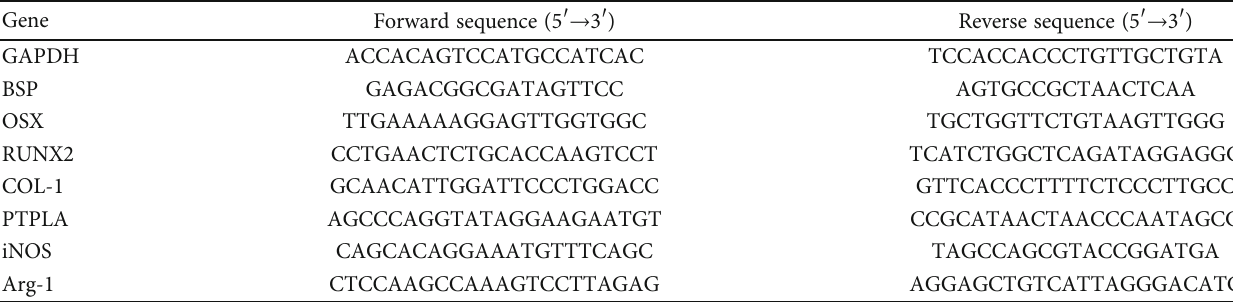
Table 1: mRNA primer sequences used in this study. Gene Forward sequence (5 ′ → 3 ′ ) Reverse sequence (5 ′ → 3 ′